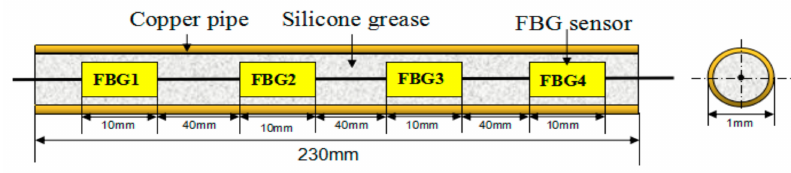
Figure 4. Schematic diagram of quasi-distributed fiber Bragg grating (FBG) temperature sensors.